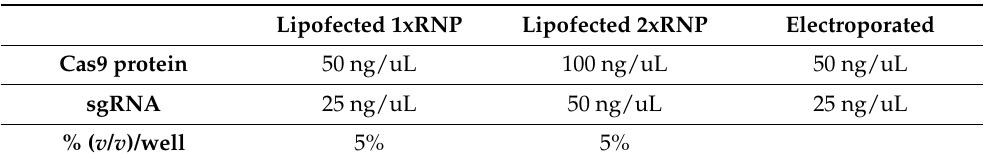
Table 2. Experimental conditions of the different groups used to evaluate the influence of the concentration of RNP in the LRNP